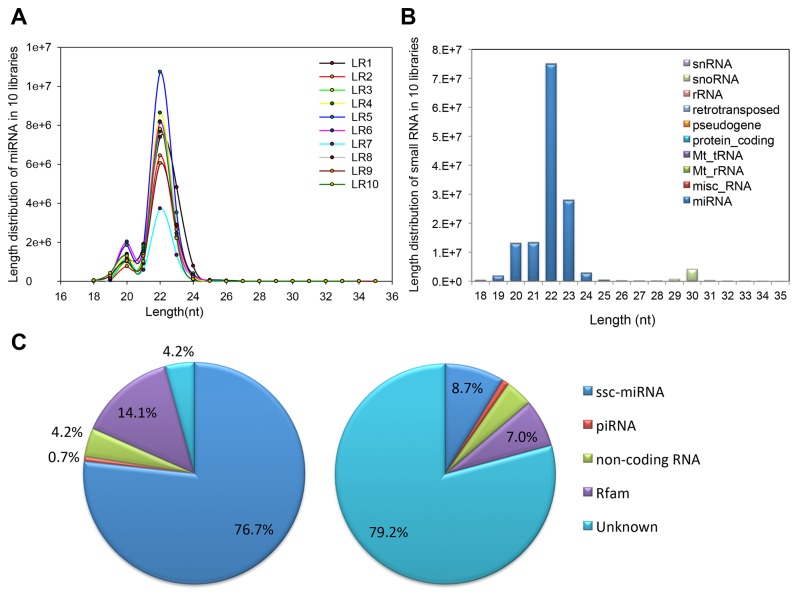
Basic analysis of Sequencing data.
A–B. Sequence length distribution of known miRNAs (A) and small RNAs (B); C. Count number distribution of Total Reads (left) and Unique Small RANs (right).